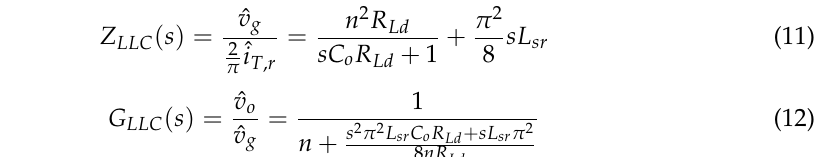
Figure 7. Second-order small-signal model of full-bridge LLC resonant converter. According to Figure 7, the input impedance and voltage transfer function of the full- bridge LLC resonant converter when used as the DCT are shown in (11) and (12),